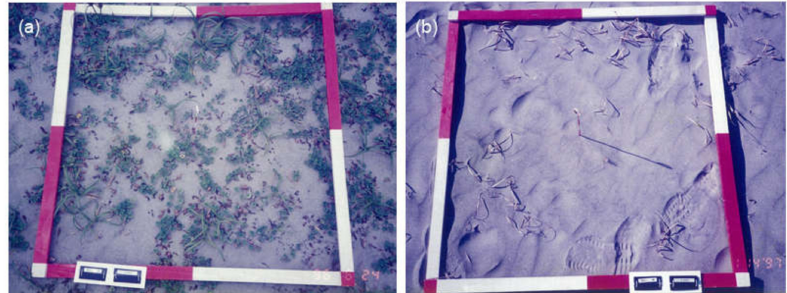
Figure 10. Photos of vegetation in a square mesh taken on 24 June 1996 ( a ) and 14 January 1997 ( b ).